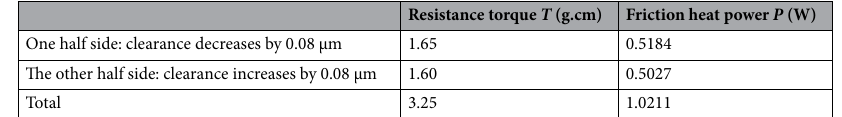
Table 3. Gas film characteristics of two half sides at the same end of the rotor with 0.08 μm radial offset.